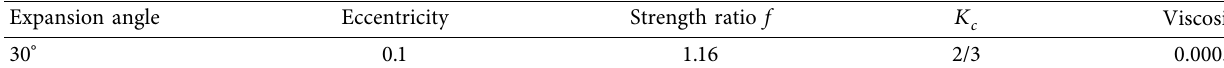
Figure 10: Stress-strain model for UHPC: (a) compression and (b) tension. Table 5: Parameters for the damaged plasticity model of UHPC.